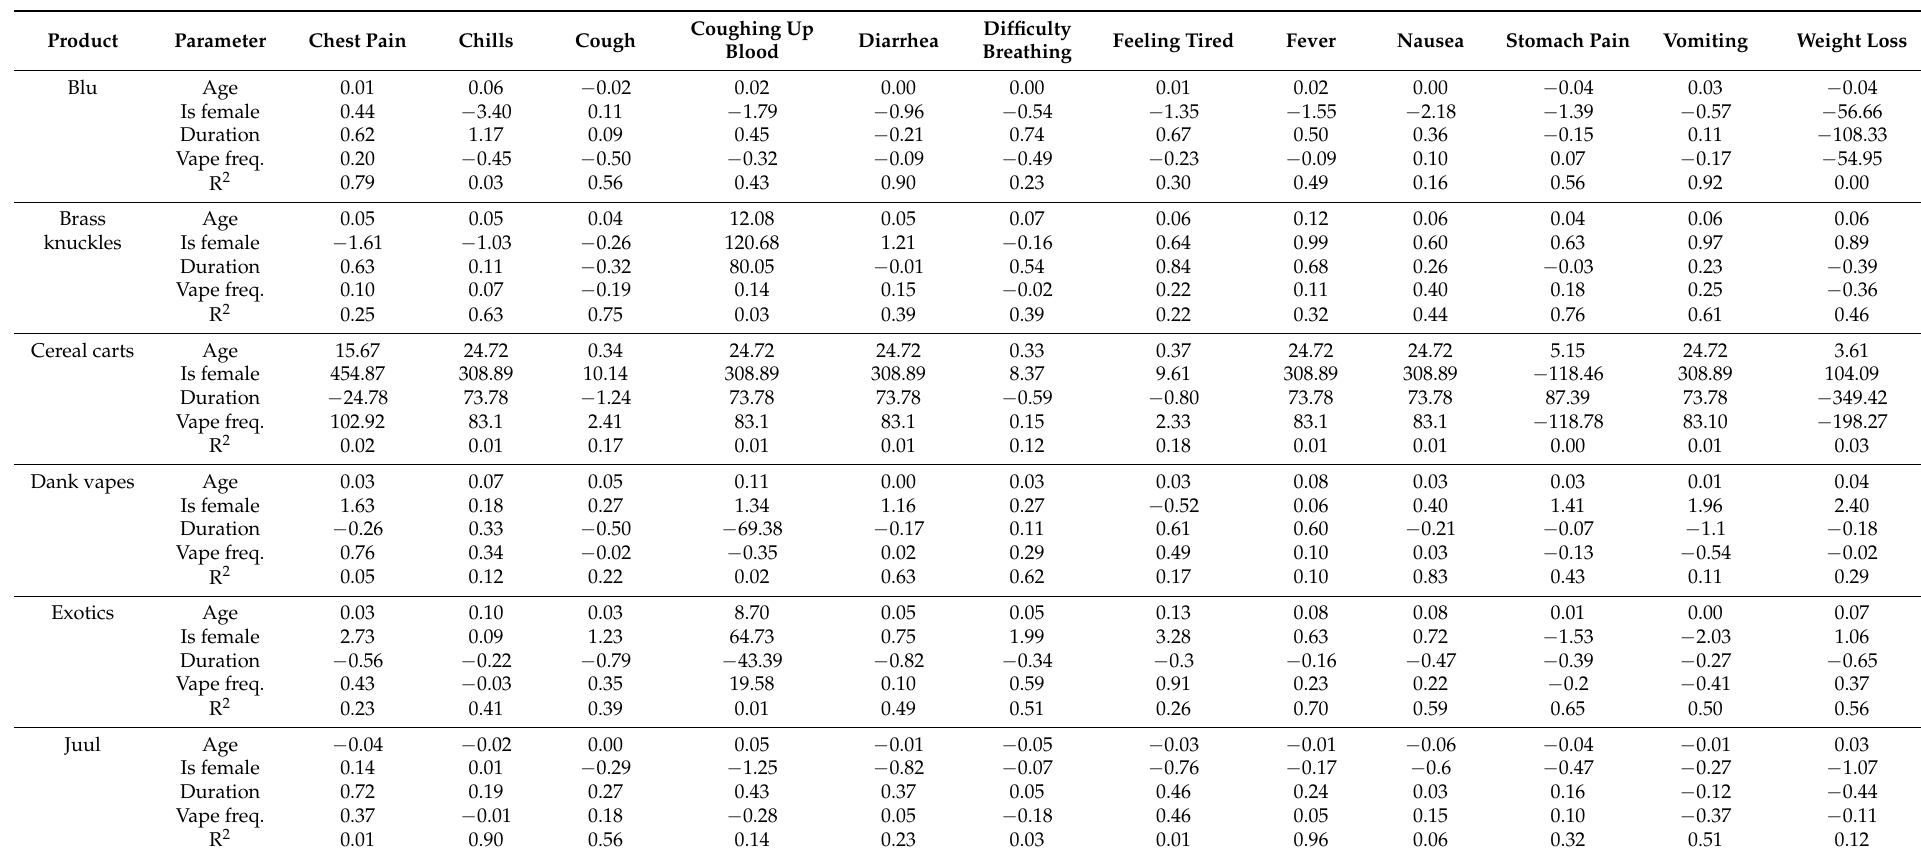
Table A2. Logistic regression model coefficients for separate products. Stars denote statistically significant results ( p < 0.05, with Bonferroni correction for 12 brands and 12 adverse reactions). Duration refers to the reported duration of